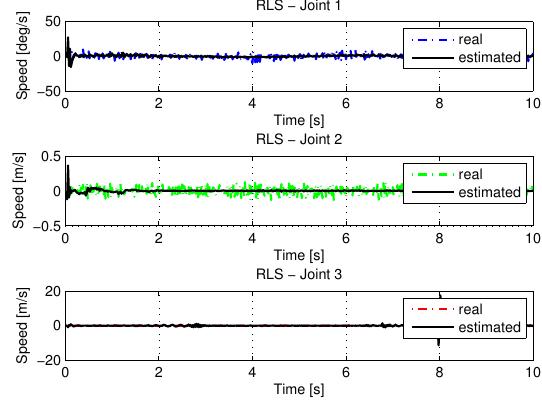
Figure 24. Speed of joints with LS with noise.